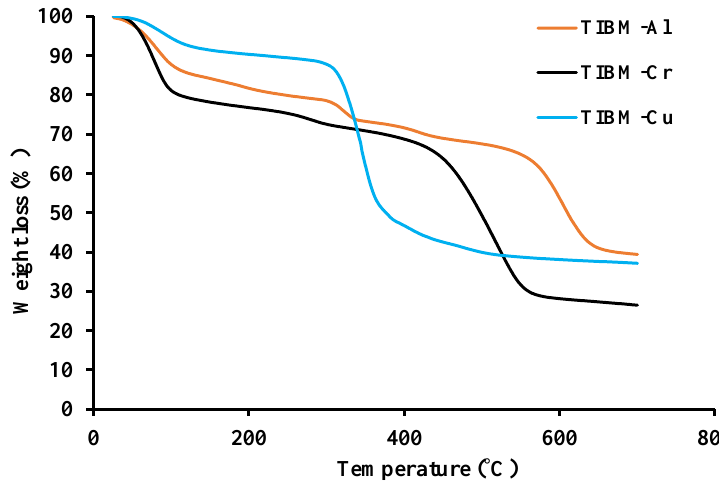
Figure 5. Thermal degradation graphs for TIBM-Al, TIBM-Cr, and TIBM-Cu.